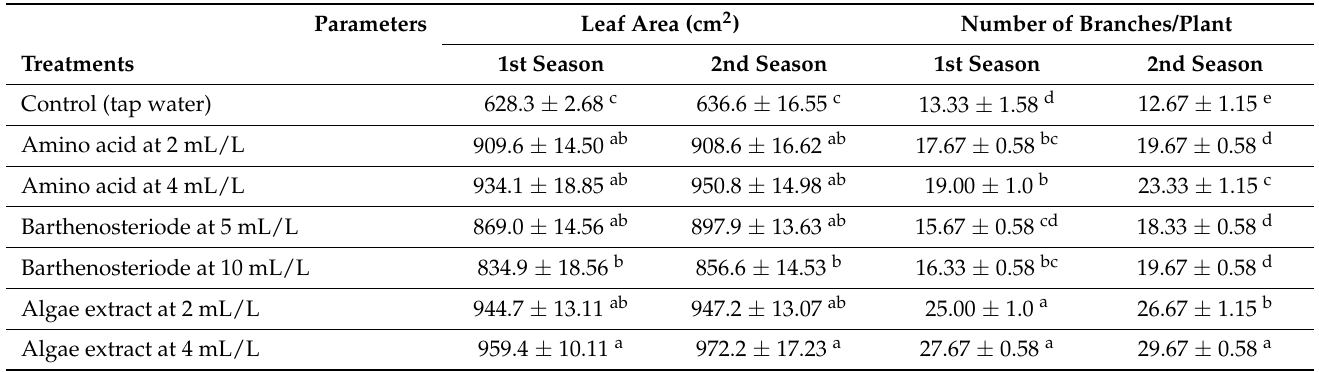
Table 3. Effect of bio-stimulant treatments on chia leaf area/(cm 2 ) and number of